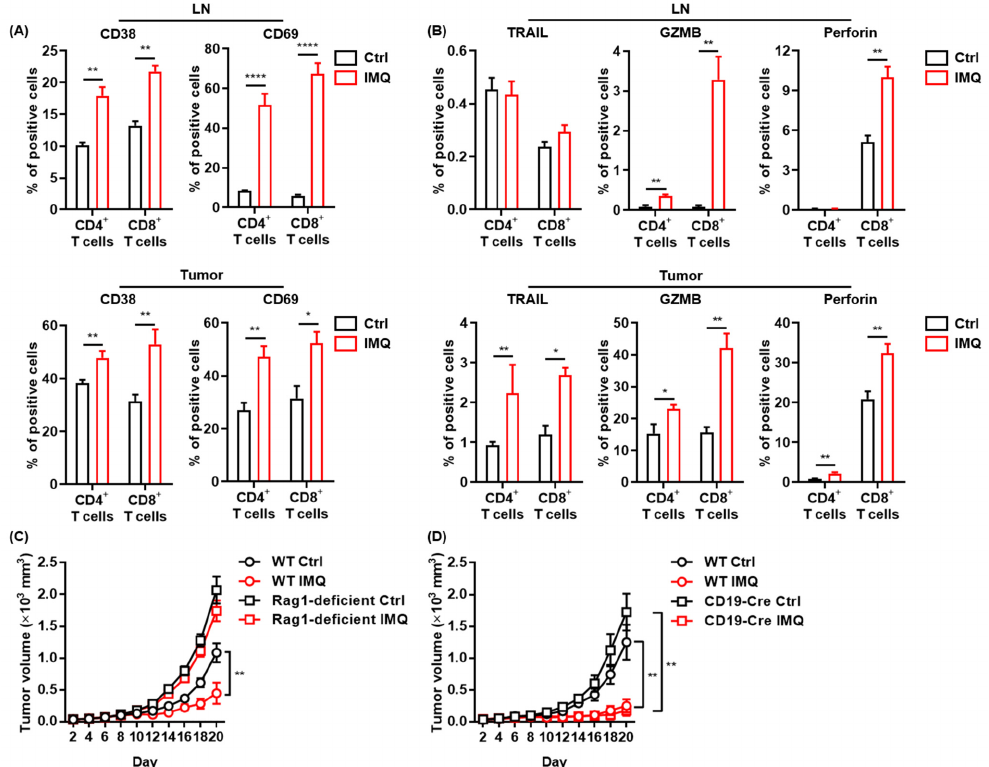
Figure 3. The antitumor effect of IMQ is dependent on adaptive immunity. ( A , B ) Flow cytometric analysis of expression of CD38, CD69 ( A ), TRAIL, GZMB, and perforin ( B ) in CD4+ T cells and CD8+ T cells in LNs and tumors 5 (CD69) or 7 (CD38, TRAIL, GZMB, and perforin) days after tumor inoculation with IMQ application at day 4 ( n = 12 [CD69] or 6 [CD38, TRAIL, GZMB, and perforin] in each group). ( C , D ) Time course of the tumor volume after 2 × 10 6 MC38 colon cancer cells were intradermally inoculated into the backs of Rag1-deficient mice ( B ) or CD19-Cre transgenic mice ( C ) with topical IMQ application or no treatment ( n = 11 in Rag1-deficient mice with IMQ application and n = 12 in Rag1-deficient mice with no treatment, homozygous CD19-Cre transgenic mice with topical IMQ application or no treatment). WT: wildtype, Ctrl: control, IMQ: imiquimod, LNs: lymph nodes., TRAIL: tumor necrosis factor-related apoptosis-inducing ligand, GZMB: granzyme B. Error bars indicate ±1 SEM; * p < 0.05, ** p < 0.01, **** p < 0.0001.